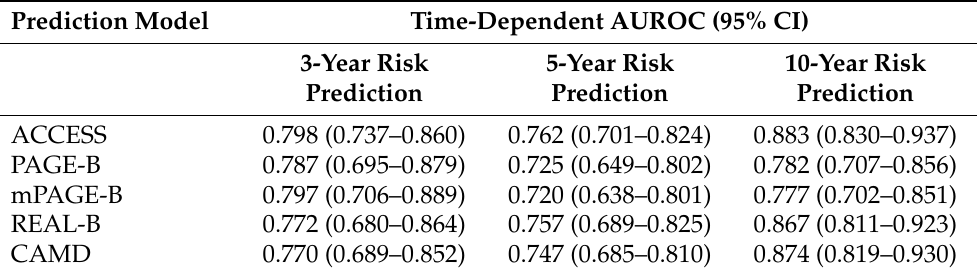
Table 4. Areas under the ROC Curves for predicting the 3-, 5-, and 10-year hepatocellular carcinoma risk using ACCESS and other scores in the validation cohort ( n =